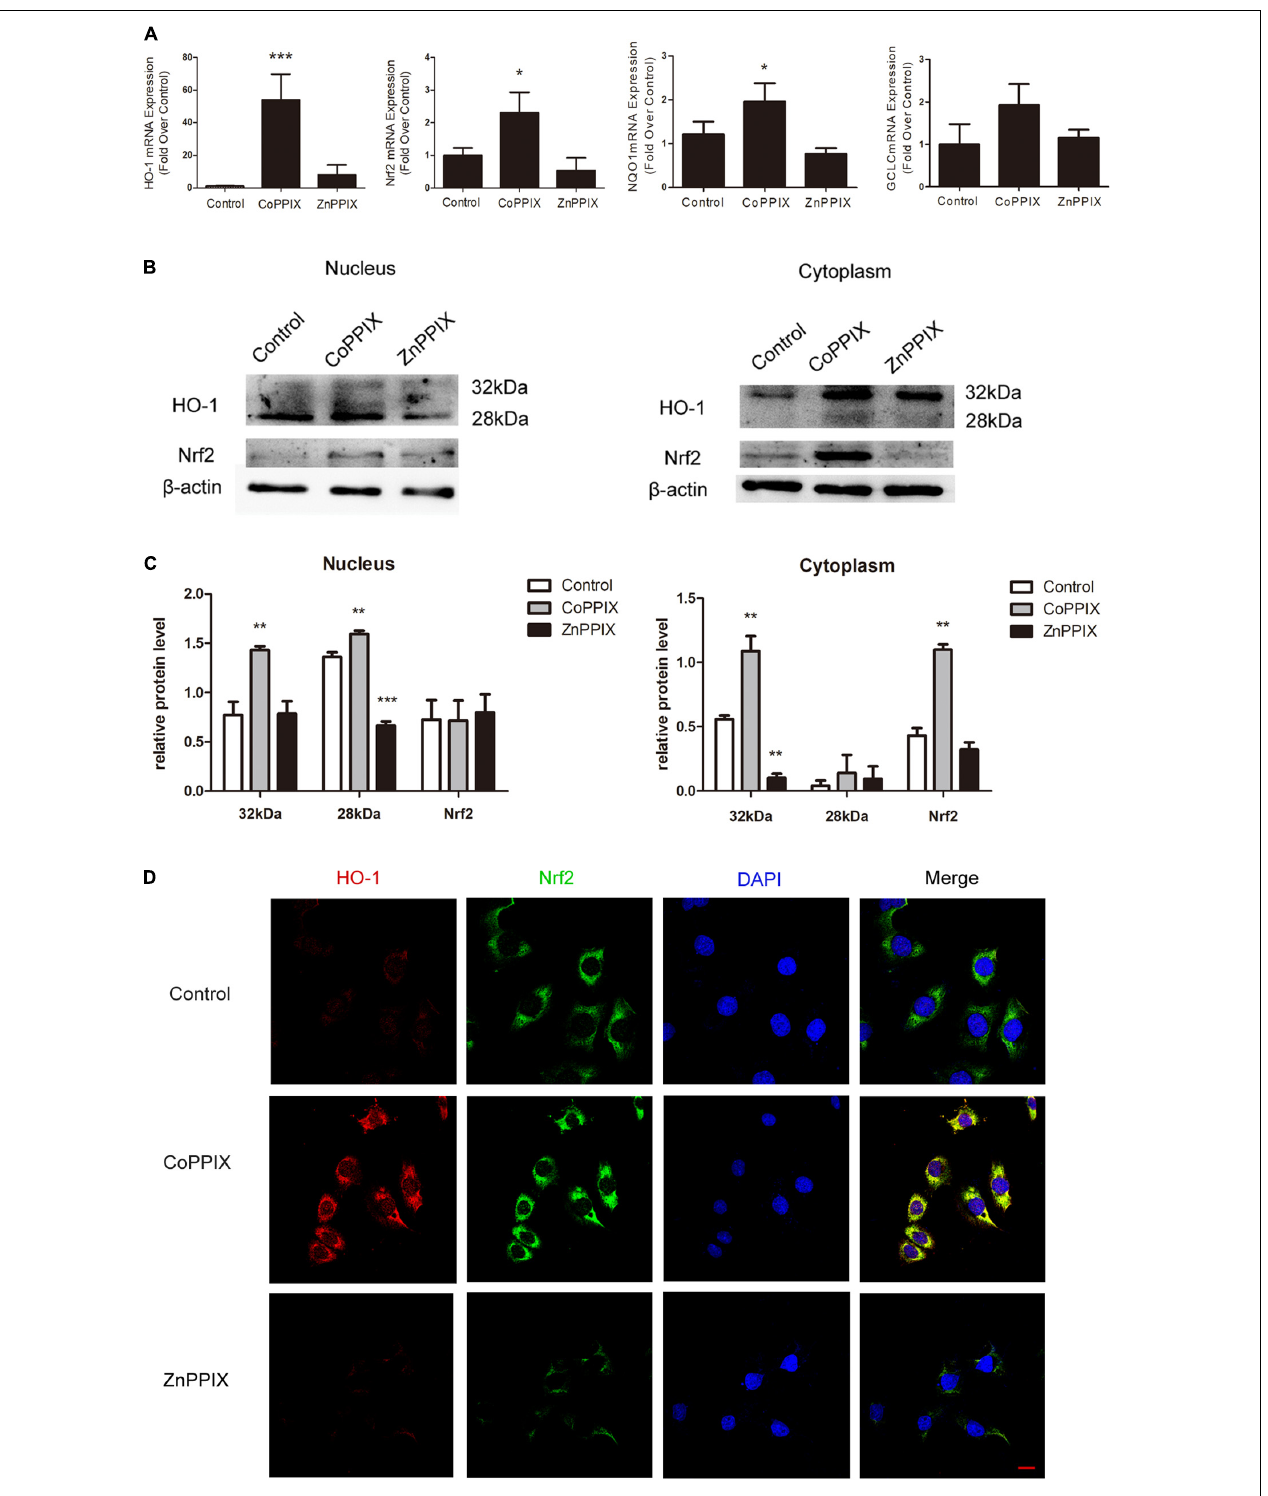
FIGURE 7 | Heme oxygenase-1 (HO-1) induction increased the expression of Nrf2. (A) The mRNA levels of HO-1, Nrf2, NQO1, and GCLC in the organs of Corti incubated with CoPPIX or ZnPPIX for 12 h (* P < 0.05, *** P < 0.001, n = 3). (B) The level of HO-1 and Nrf2 expression were determined by Western blot in the nuclear and cytoplasmic fractions of the organs of Corti incubated with CoPPIX or ZnPPIX for 12 h. (C) The signal of HO-1 and Nrf2 [from (B) ] quantitated after normalization to β - actin and represented in bar diagrams (* P < 0.05, ** P < 0.01, n = 3). (D) Immunofluorescence staining of HEI-OC1 in different groups. Scale bar = 20 µ m.